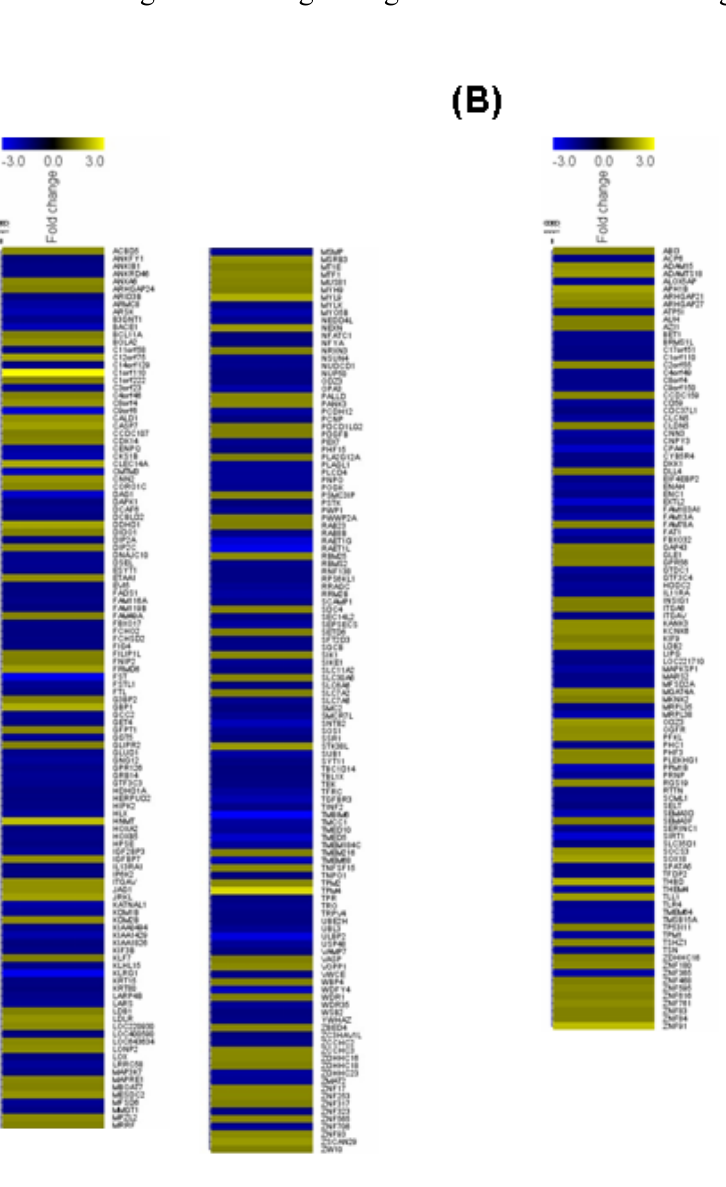
Figure 3. Heat map diagrams illustrating the significantly changed ( p < 0.05 with a fold change value >1.5 as compared to control cells) genes in HUVECs with gene silencing